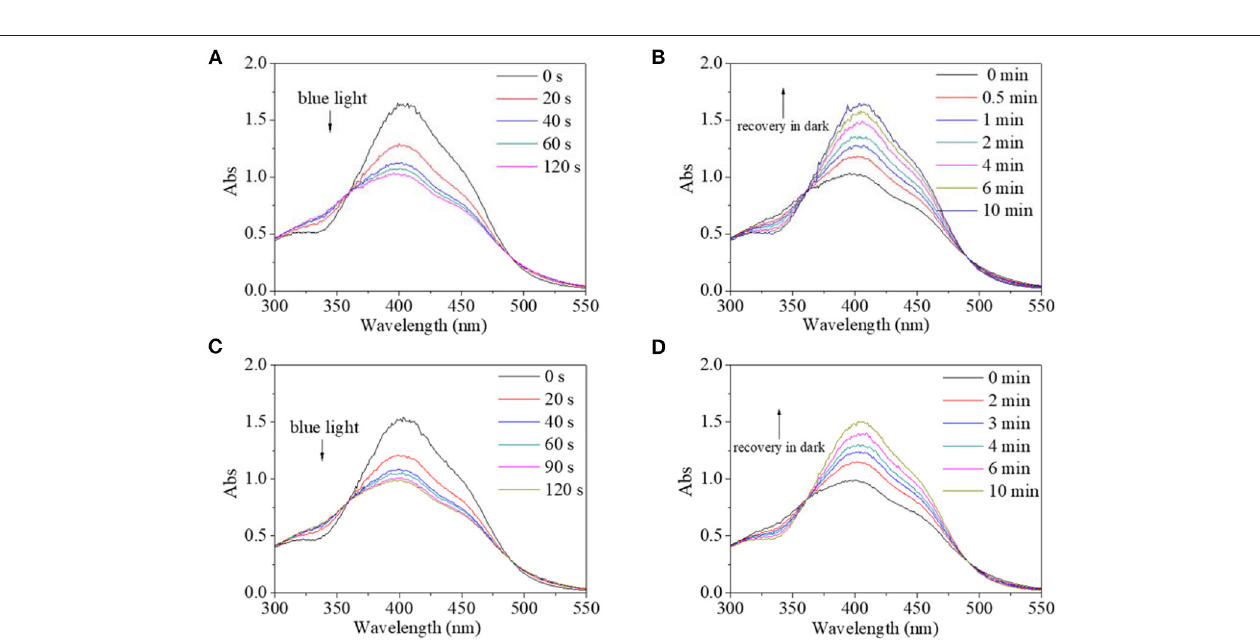
FIGURE 11 | UV spectra of PBLG2 solution with 5% water (A,B) and 10% water (C,D) as a function of irradiation time (A,C) and recovery time (B,D) . Irradiation was performed under blue light, and recovery process was performed under darkness and room temperature. Polymer concentration was 0.85 mg/mL.